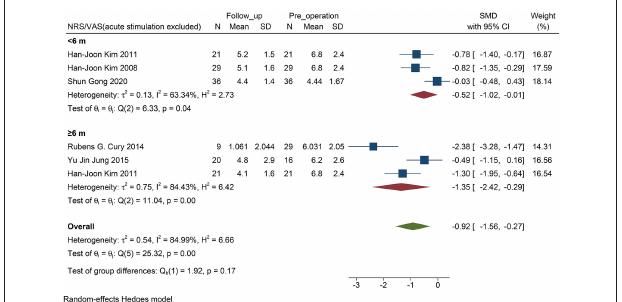
FIGURE 5 | Forest plots of pain severity with PD follow-up subgroups: The SMD of pain severity accessed by the score of NRS/VAS excluded the accurate stimulation study, shows a significant change between baseline and follow-up visit in all subgroups. PD, Parkinson’s disease; NRS, numerical rating scale; VAS, visual analog scale; SMD, standardized mean difference; N, sample